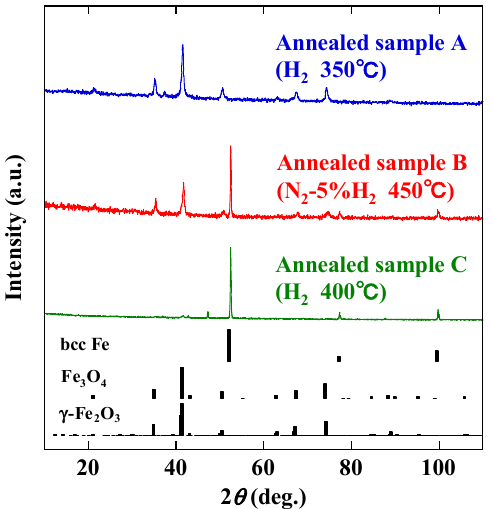
Figure 4. XRD patterns of annealed samples A, B and C, and reference patterns for bcc Fe, Fe 3 O 4 and γ -Fe 2 O 3.